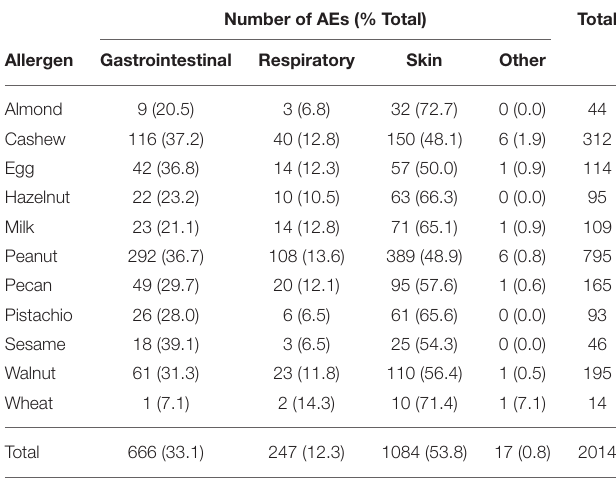
TABLE 4 | Adverse events by allergen and organ